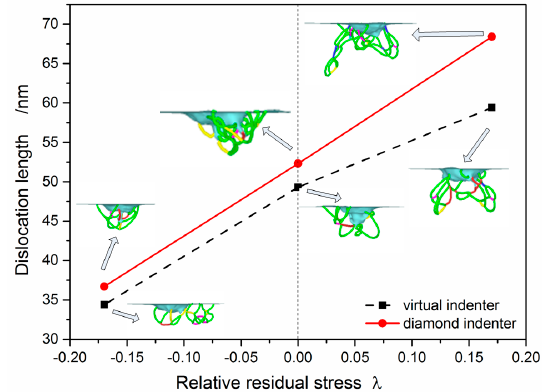
Figure 16. Dislocation length vs. relative residual stress under the same indentation depth ( 0.9nm h